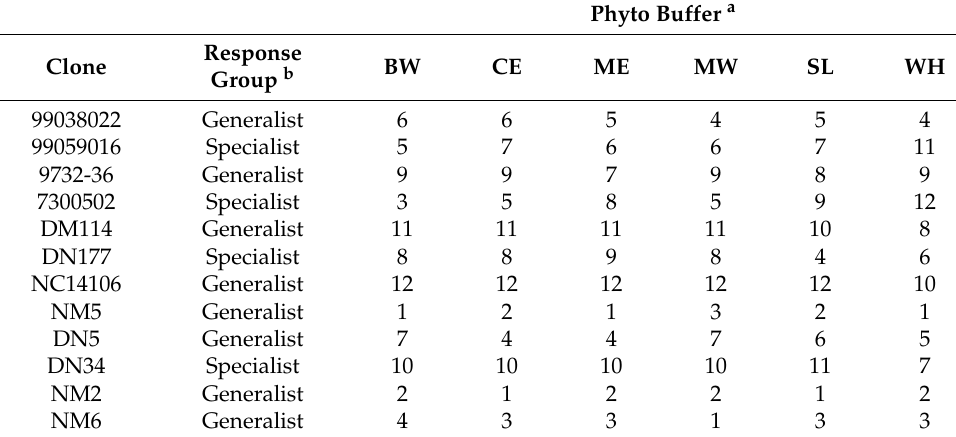
ameter ( P = 0.0018), and volume ( P = 0.0001) of the 2017 buffer group trees (Table S3). VOLUME 2017 of trees measured in 2017 (VOLUME 2017(2017) ) ranged from 3.1 ± 54.4 (‘7300502’ at Whitelaw) to 459.6 ± 22.6 cm 3 (‘7300502’ at Slinger), with an overall mean of 132.0 ± 38.7 cm 3 , while VOLUME 2017(2018) (i.e., 2017 buffer group trees measured in 2018) ranged from 503.5 ± 1619.6 (‘7300502’ at Whitelaw) to 13,027.0 ± 1402.6 cm 3 (‘NM2’ at Slinger), with an overall mean of 5765.2 ± 1132.3 cm 3 (Table 5). VOLUME 2017(2019) ranged from 1668.7 ± 3018.1 (‘7300502’ at Whitelaw) to 26,652.0 ± 1848.0 cm 3 (‘NM5’ at Menomonee Falls (East)), with an overall mean of 10,530.6 ± 2109.5 cm 3 (Table 5).